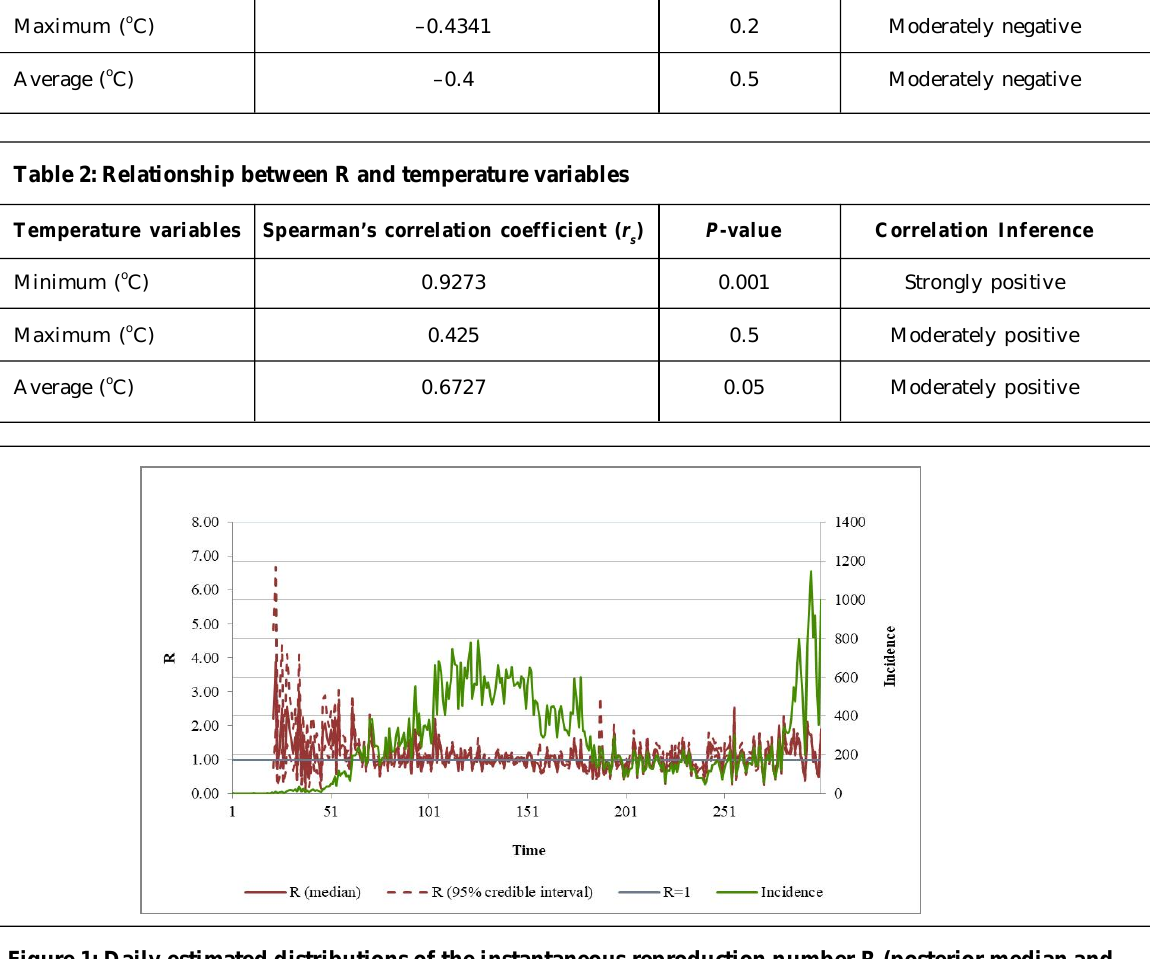
Figure 1: Daily estimated distributions of the instantaneous reproduction number R (posterior median and 95% CrI), based on NCDC epidemiological data for COVID-19 over 300 daily incidences COVID-19